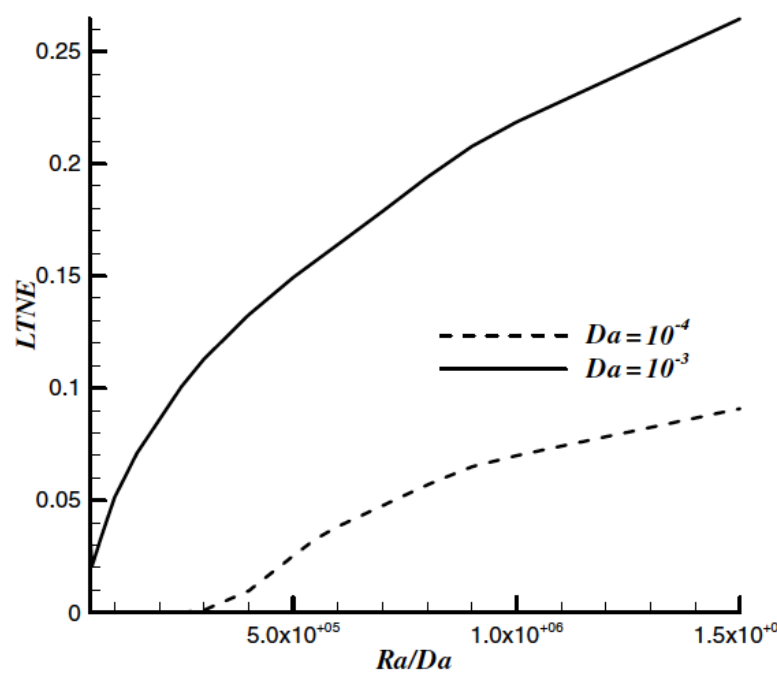
Figure 36. Profiles of LTNE parameter with Rayleigh number, for two Darcy numbers, presented by Khashan et al.